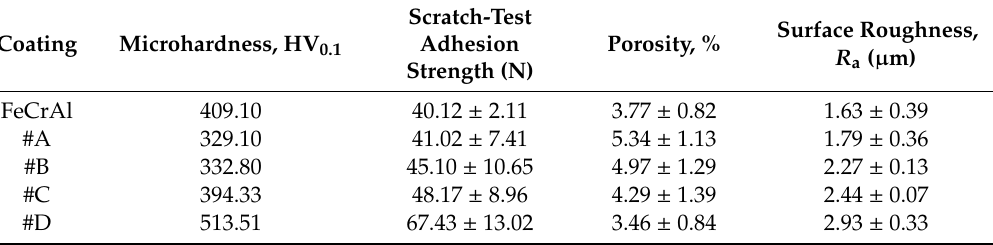
Table 3. Properties of the